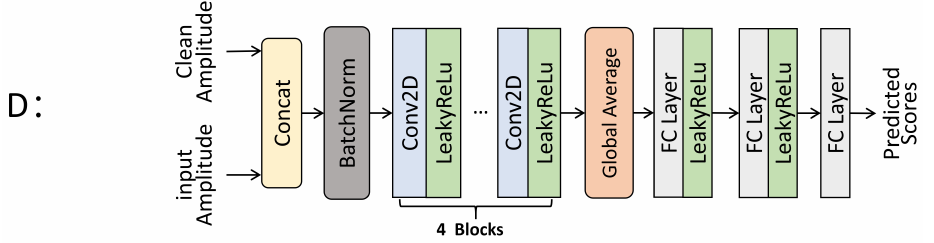
Figure 5. The proposed structure of the perceptually guided discriminator, whose body is four two-dimensional CNNs, ultimately outputs a normalised prediction score through feature